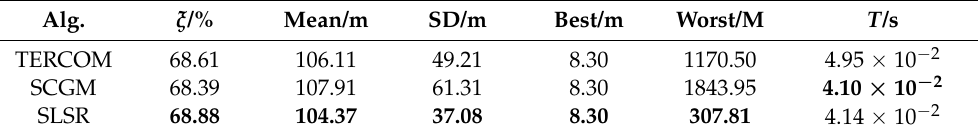
Table 3. Statistical results for TERCOM’s out-of-domain mismatches based on different algorithms.